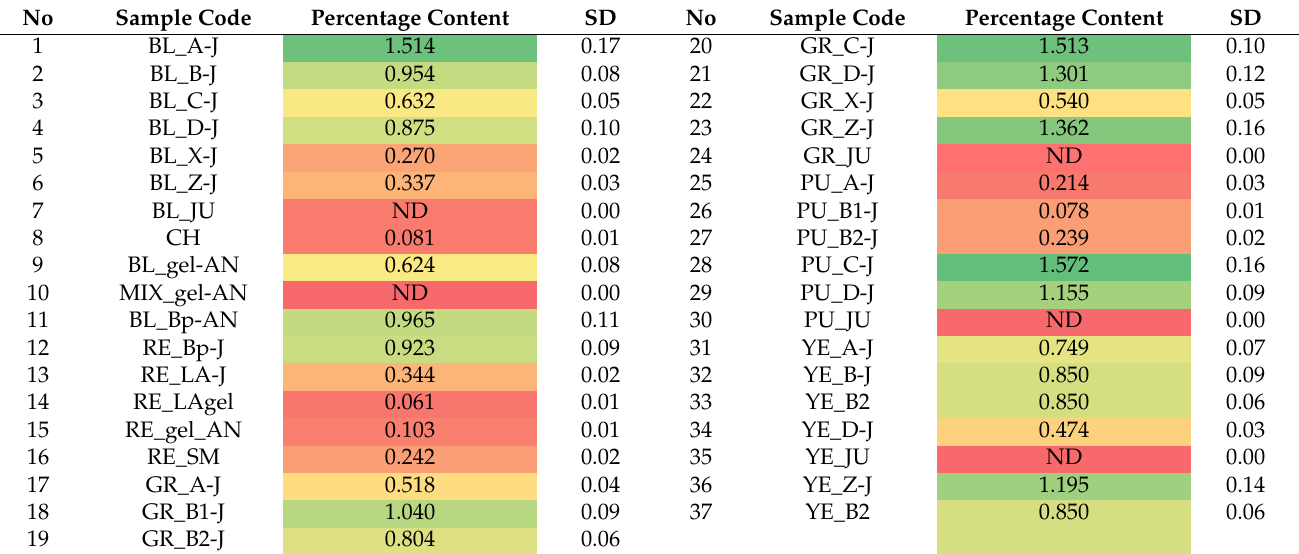
Table 2. The results of the quantitative determination of glucotropaeolin in the studied extracts (green color corresponds with the highest quantity of G2 in the extracts, wheras red colour shows the samples with the lowest calculated